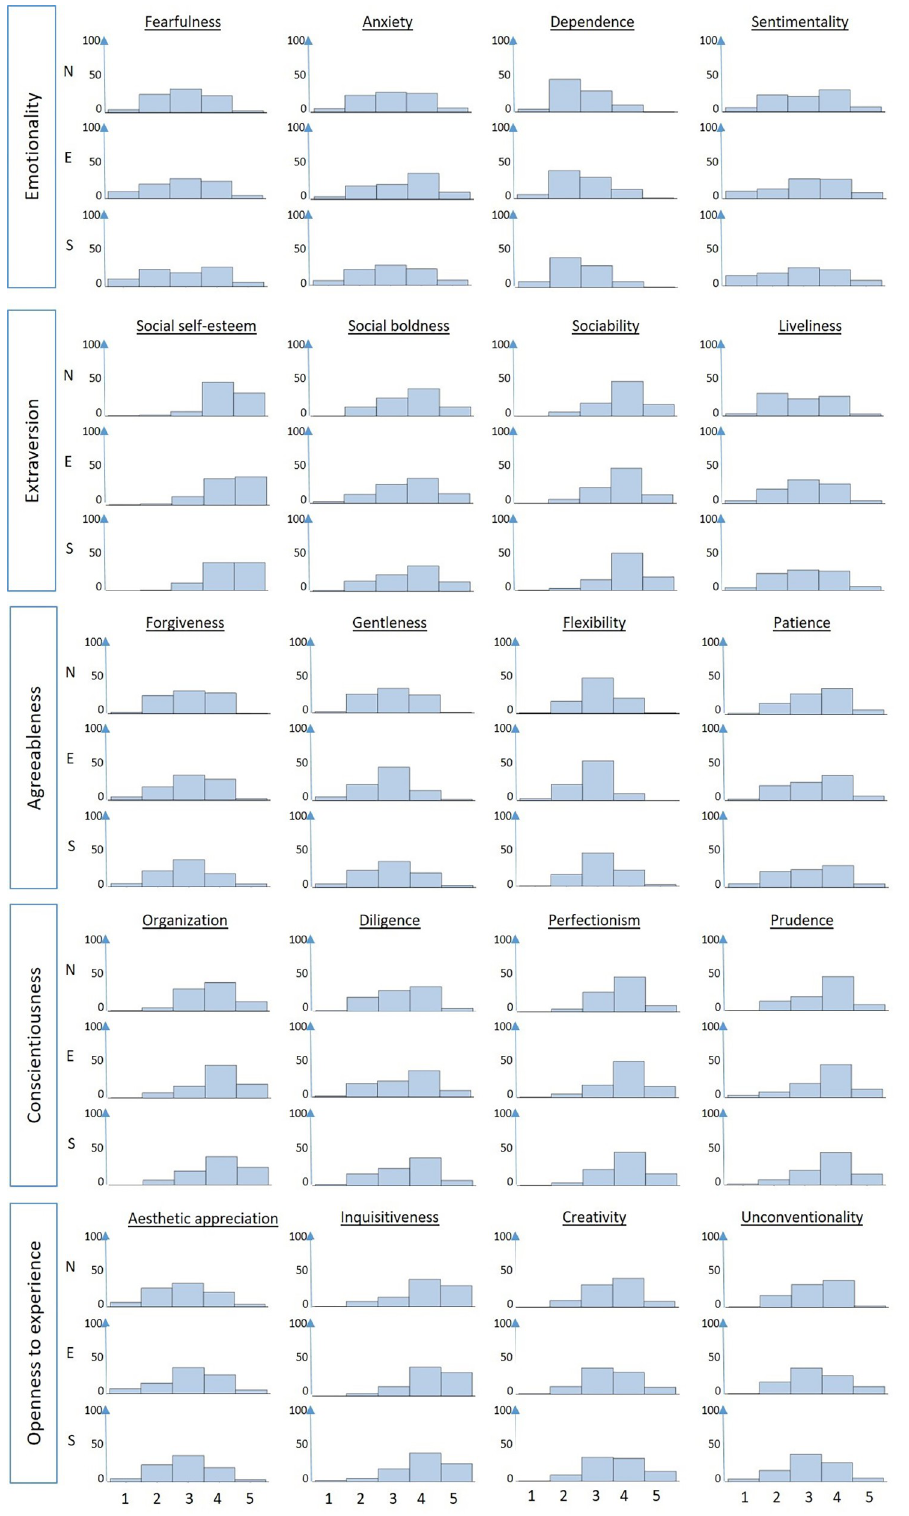
Fig 2. Distribution of the Likert scale ratings of HEXACO personality facets for dairy farmers in three different regions of Germany (n north = 181; n east = 172; n south = 226).